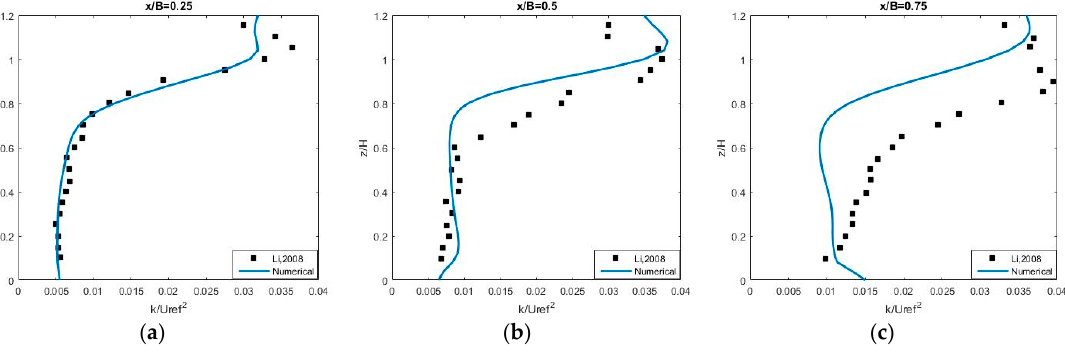
Figure 15. Turbulence Intensity at x/b = 0.25 ( a ), x/b = 0.5 ( b ) and x/b = 0.75 ( c ) with AR = 0.5. Table 3. Evaluation of flow parameters between the numerical results and experimental data.